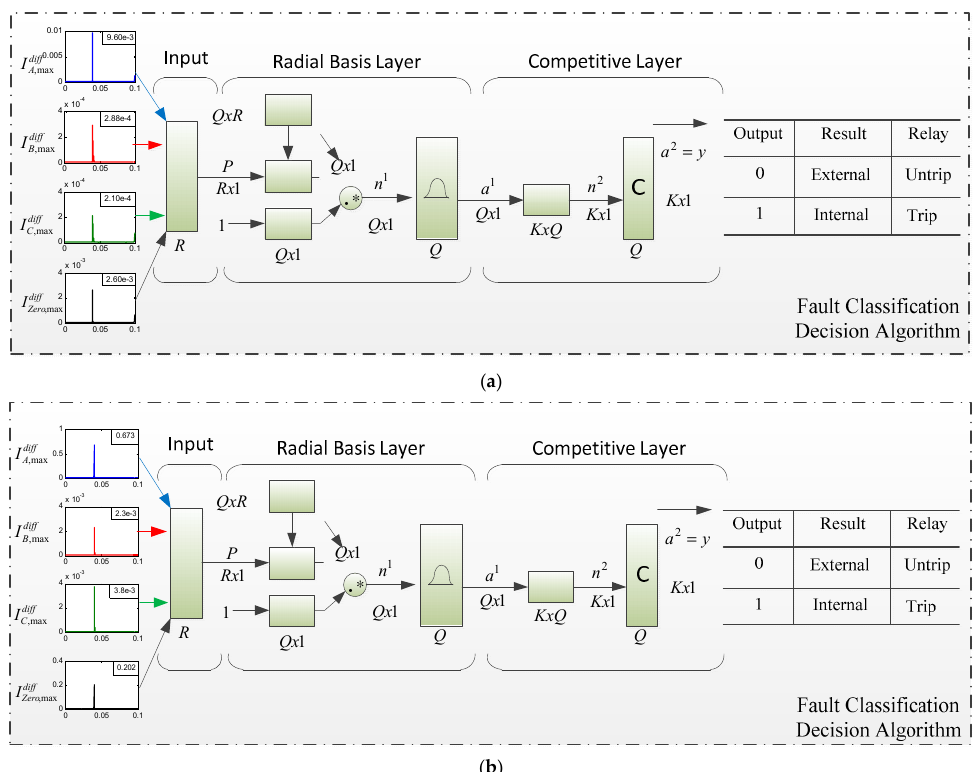
Figure 9. PNN input pattern (maximum coefficients (cD1) in scale 1 of differential current signal): ( a ) case of an internal malfunction; ( b ) case of an external fault.